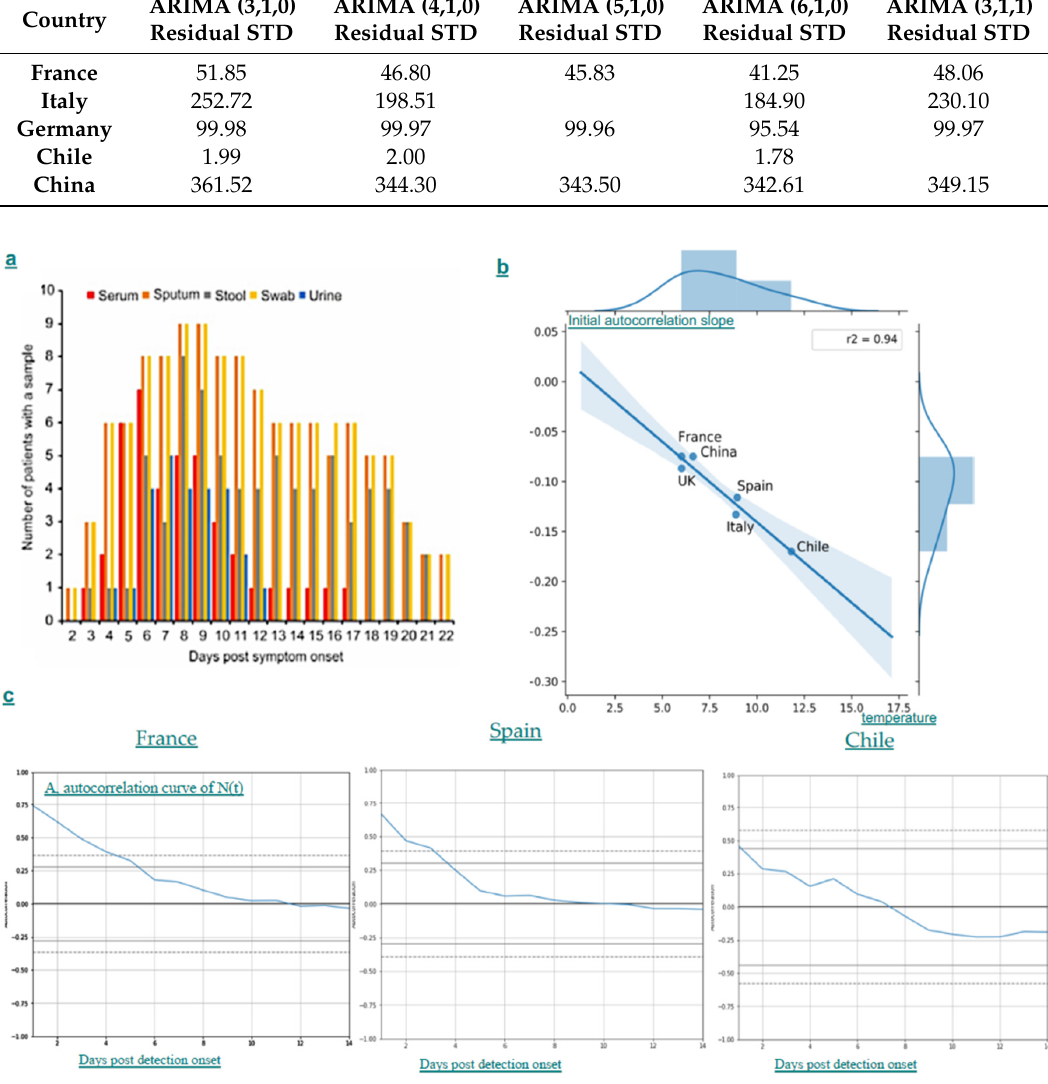
Figure 2. ( a ) Virulence of covid-19 in liquids and secretions (from [27]); ( b ) Linear regression of negative initial autocorrelation slope on mean weather temperature of six countries, France, UK, Spain, Italy, China and Chile (Pearson correlation coefficient R = 0.97, one-tailed p = 0.001). ( c ) Autocorrelation function A for three countries, France, Spain and Chile showing during